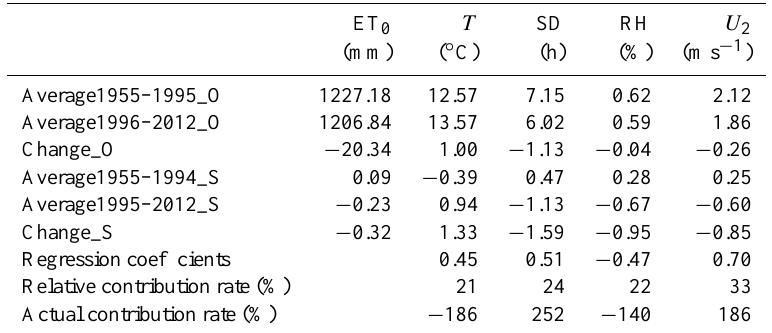
Figure 6. The variations of the (a)maximum and (b) minimum value of ET 0 by assigning a continuous increase/decrease of the temper- ature with a 2 ◦ C interval based on the historic maximum/minimum temperature (daily scale, T − D max / T − D min ) at 24 July 1955 and 15 January 1958, respectively. The horizontal dash line represents the historic maximum/minimum value of ET 0 in the respective year. Table 1. Contribution rate of meteorological variables to the change of ET 0 (“O” represents original data. “S” represents the standardized data. 1995 is the turning point identified by M–K